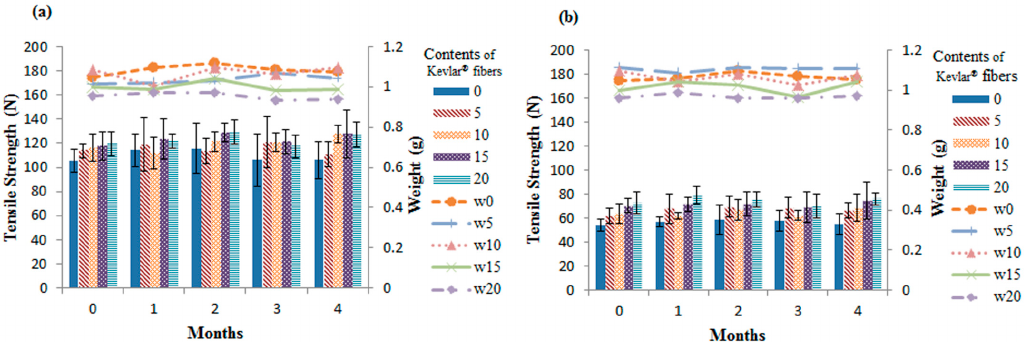
Figure 2. Tensile strength and weight along the (a) CD and (b) MD of recycled Kevlar ® /PET/LPET nonwoven geotextiles that are immersed in H 2 O at 50 °C for 4 months .